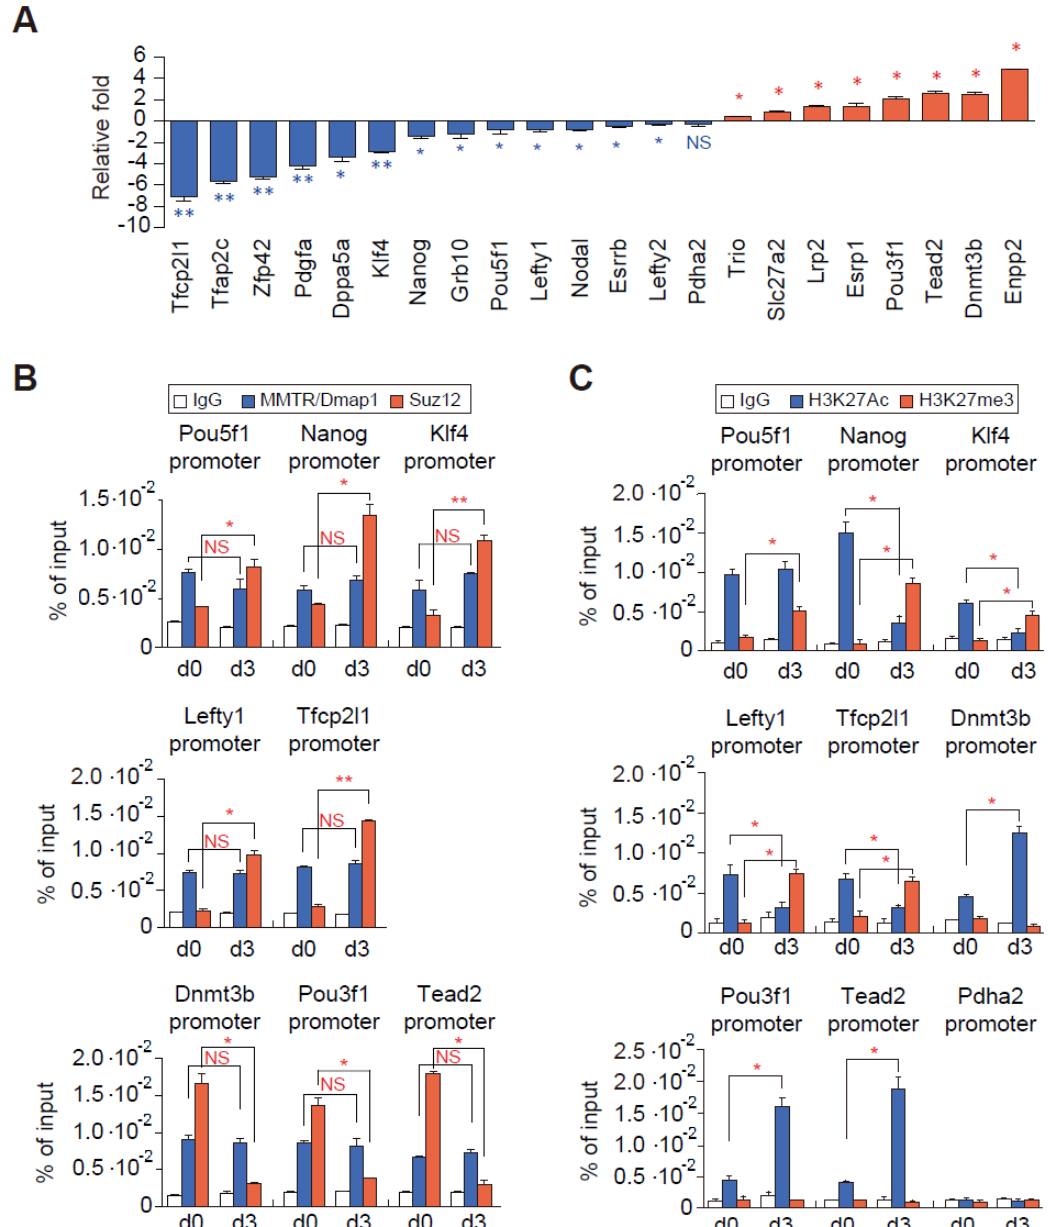
and PRC complexes regulates the MMTR / Dmap1 targeted commitment gene expressions during the maintenance and di ff erentiation of mESCs.